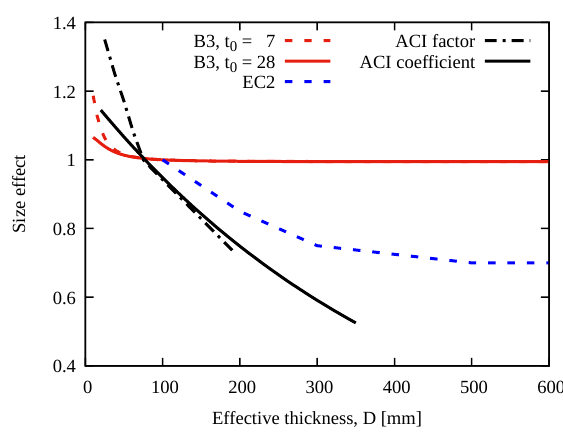
Figure 1. Size effect on ultimate drying shrinkage evaluated according to selected design codes and pre- diction